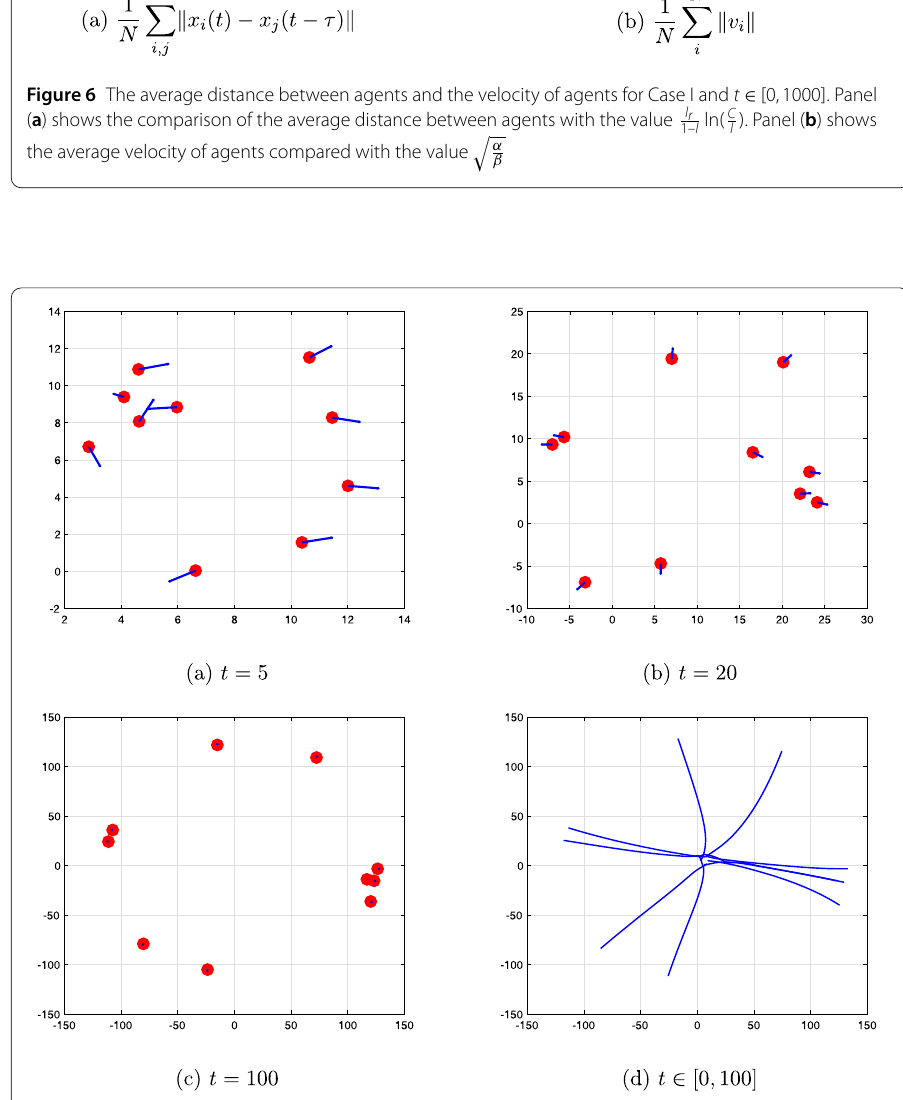
Figure 7 Simulation of the second-order swarming model with time delay ( τ = 5) for five agents, N = 10, and time t ∈ [0,100]. The corresponding parameters are given as α = 0.7, β = 0.5, C a = 5, l a = 1, C r = 1, and l r = 100. The position of each agent is depicted by a circle and the velocity is represented by a vector at agent’s